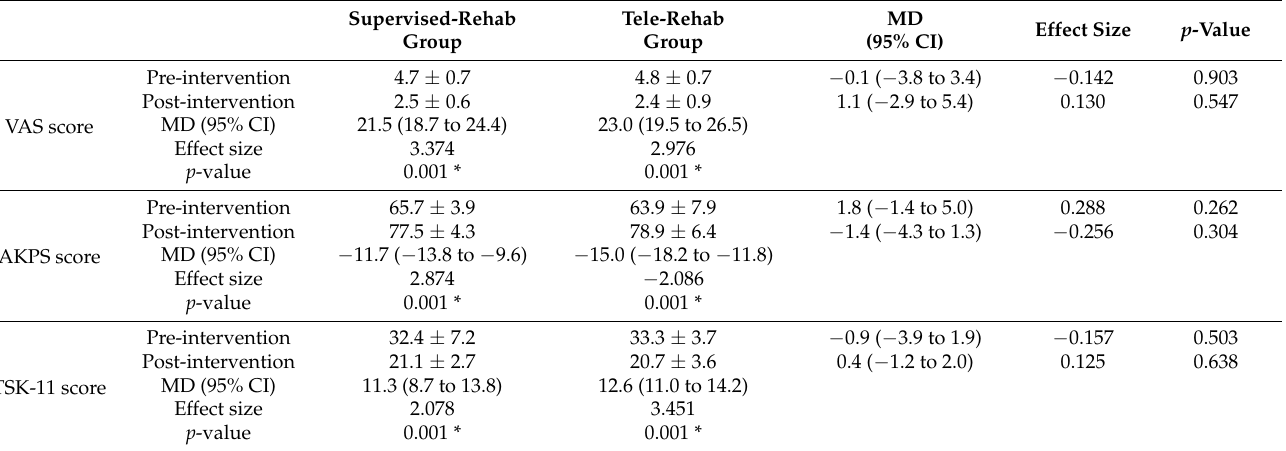
Table 3. Comparison of patient-reported outcomes in the supervised-rehab and tele-rehab groups .